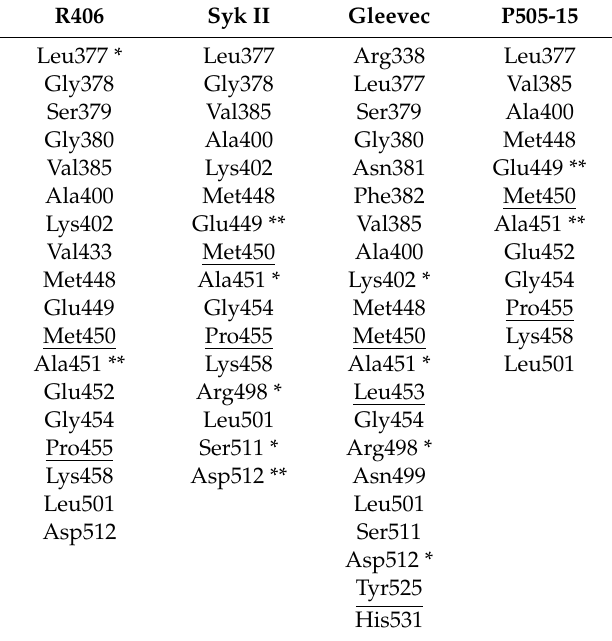
Table 4. Hydrophobic interactions and H-bonds between Syk inhibitors and proteins. The bonds are shown highlighted with * (1 H-bond) and with ** (2 H-bonds). Amino acids that are underlined have a high level of Syk specificity. The amino acid Tyr525 is double underlined, which is an autophosphorylation site of Syk protein that forms an interesting interaction with Gleevec. R406 Syk II Gleevec P505-15 Leu377 * Leu377 Arg338 Leu377 Gly378 Gly378 Leu377 Val385 Val385 Ser379